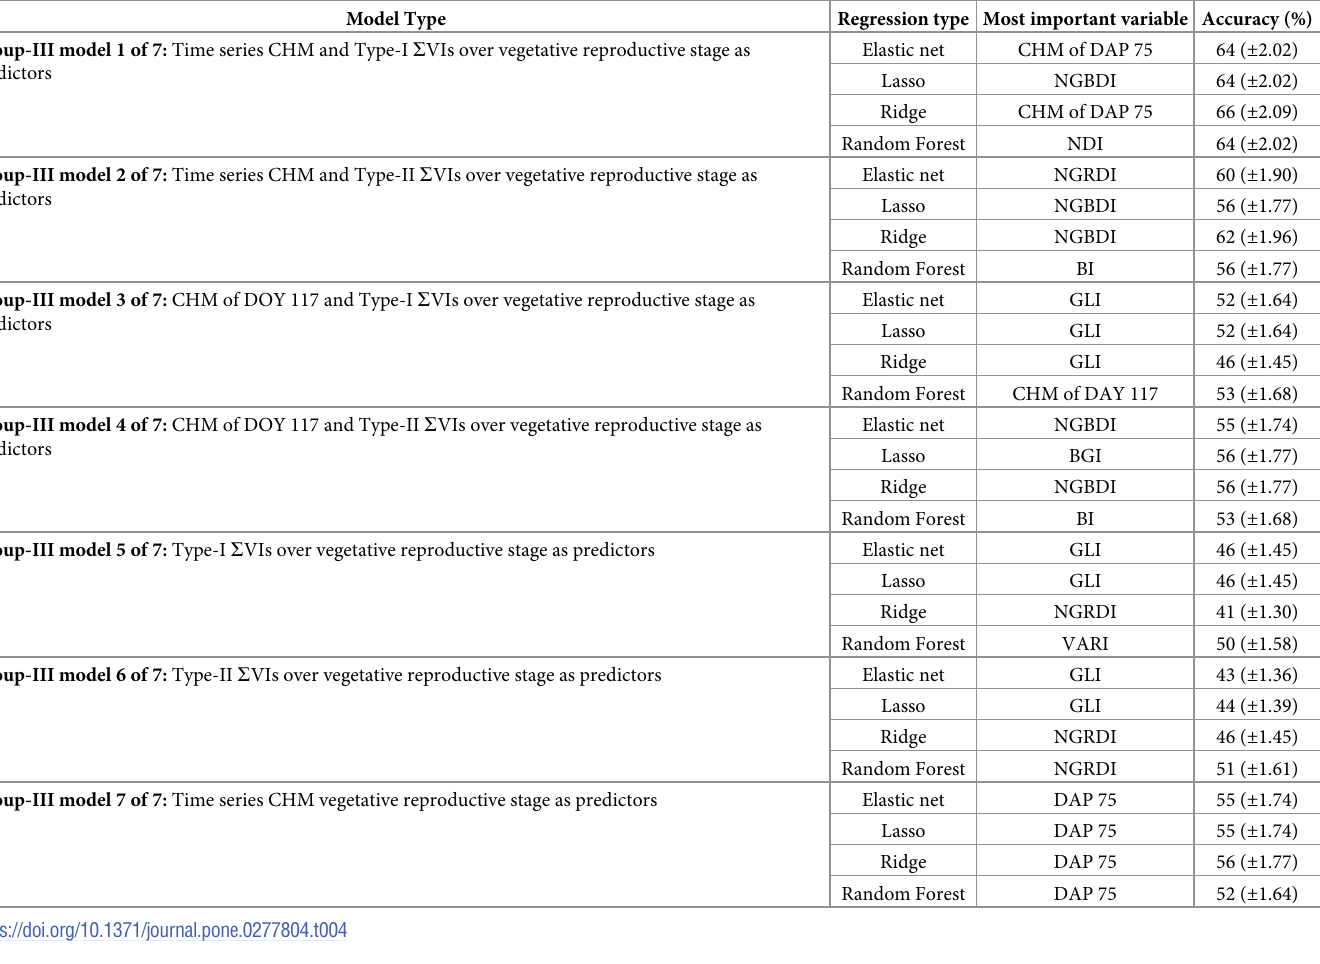
Table 4. Results of Group-III models. The results include results from regression types for each model (column 2), and both most important variables for each model for each regression type (column 3), and accuracies of each model for each regression type (column